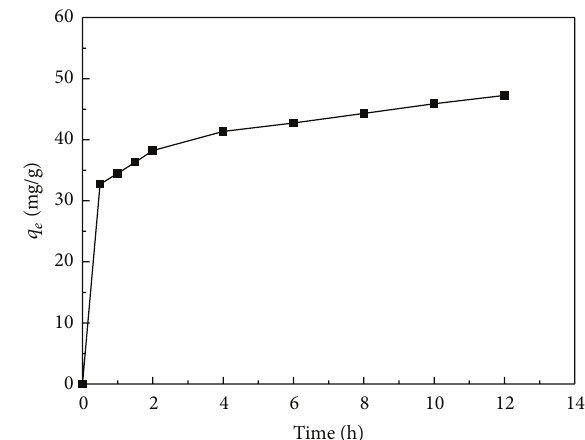
Figure 4: Effect of initial pH on the adsorption of Cr(VI). Figure 5: The Cr(VI) adsorption capacity and removal efficiency as functions with contact time (solution volume 100mL, adsorbent 20 mg, 200 rpm, 25 ∘ C, initial Cr(VI) concentration 40